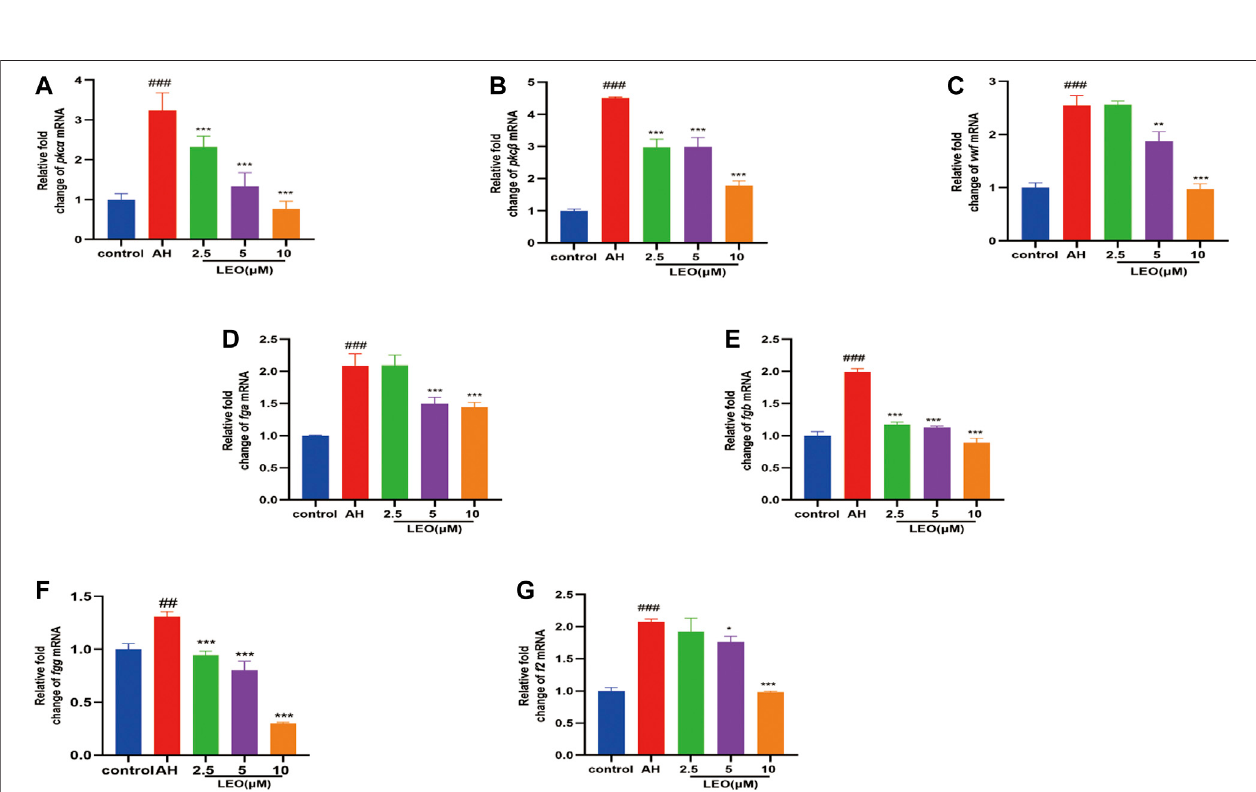
FIGURE 8 | The related mRNA expression of platelet activity and coagulation cascade in control group, AH group and AH + LEO (2.5, 5, 10 μ M) groups. (A) The mRNAexpressionsofpkc α . (B) ThemRNAexpressionsofpkc β . (C) ThemRNAexpressionsofvwf. (D) ThemRNAexpressionsoffga. (E) ThemRNAexpressionsoffgb. (F) ThemRNAexpressionsoffgg. (G) ThemRNAexpressionsoff2.Dataareexpressedasmean ± SD( n (cid:1) 3).# p < 0.05, ## p < 0.01 ,### p < 0.001 vsControlgroup;* p < 0.05 , ** p < 0.01, *** p < 0.001 vs AH group.